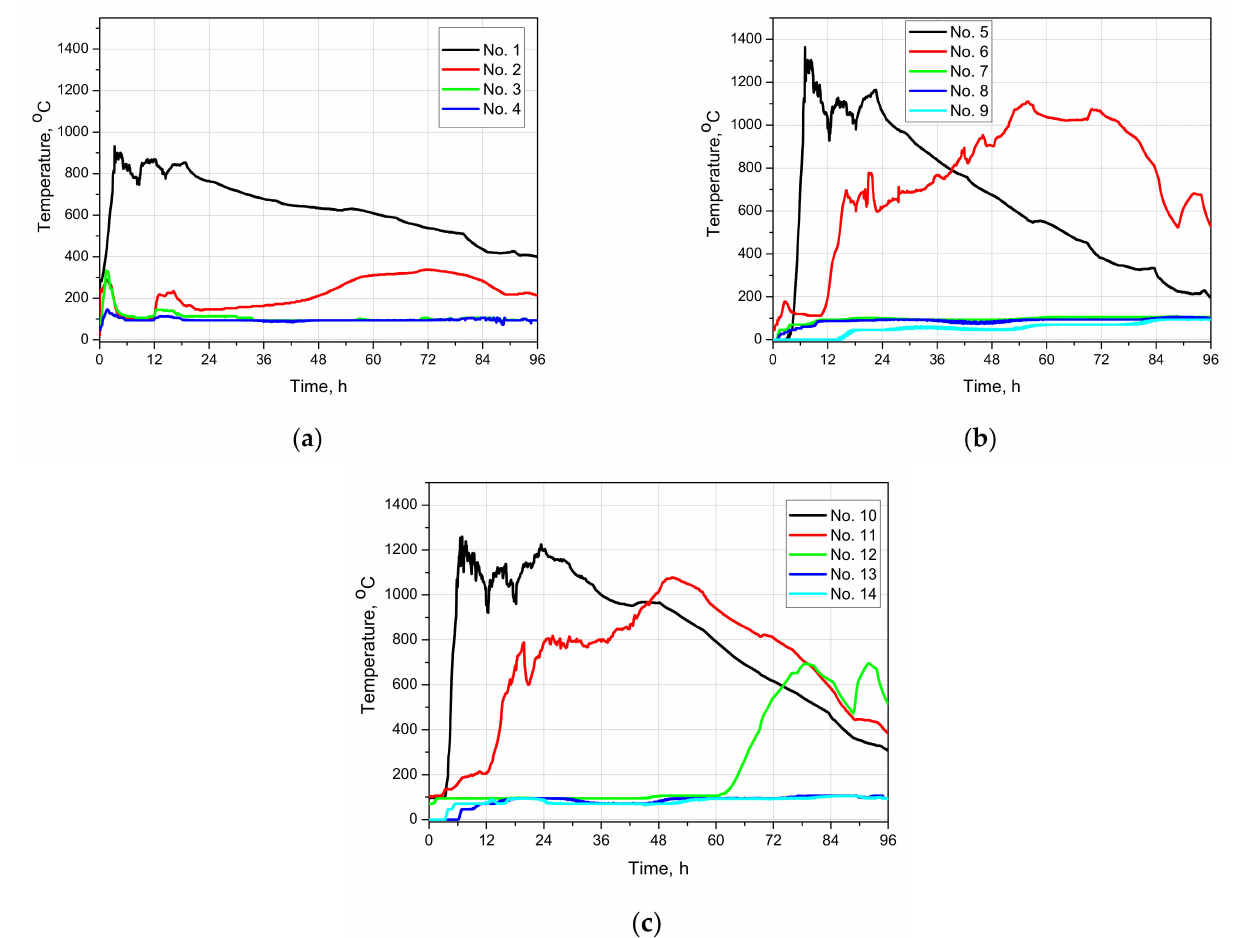
Figure 10. Temperature distribution during the Oltenia gasification experiment: ( a ) gasification channel, ( b ) 0.3 m above bottom, ( c ) 0.6 m above